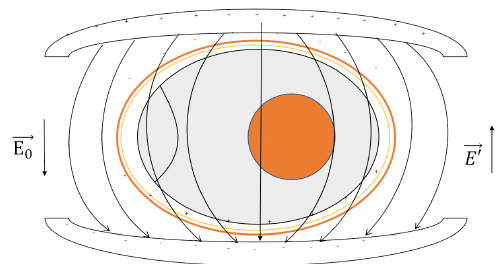
Figure 2. Schematic diagram of surface polarization of eggs in electric field.